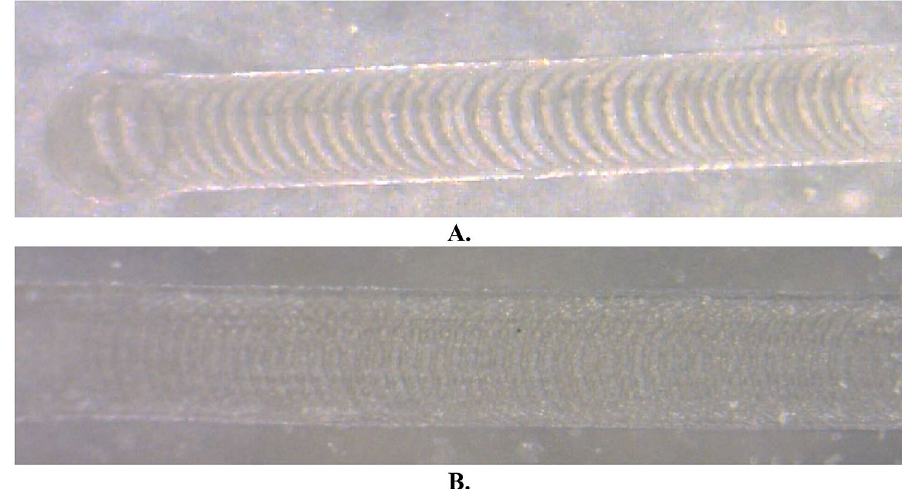
Fig. 6 Effect of rotational speed on tool movement at 38 V, feed rate of 0.6 mm/ min, 25% concentration and rotational speeds of a zero and b 5000